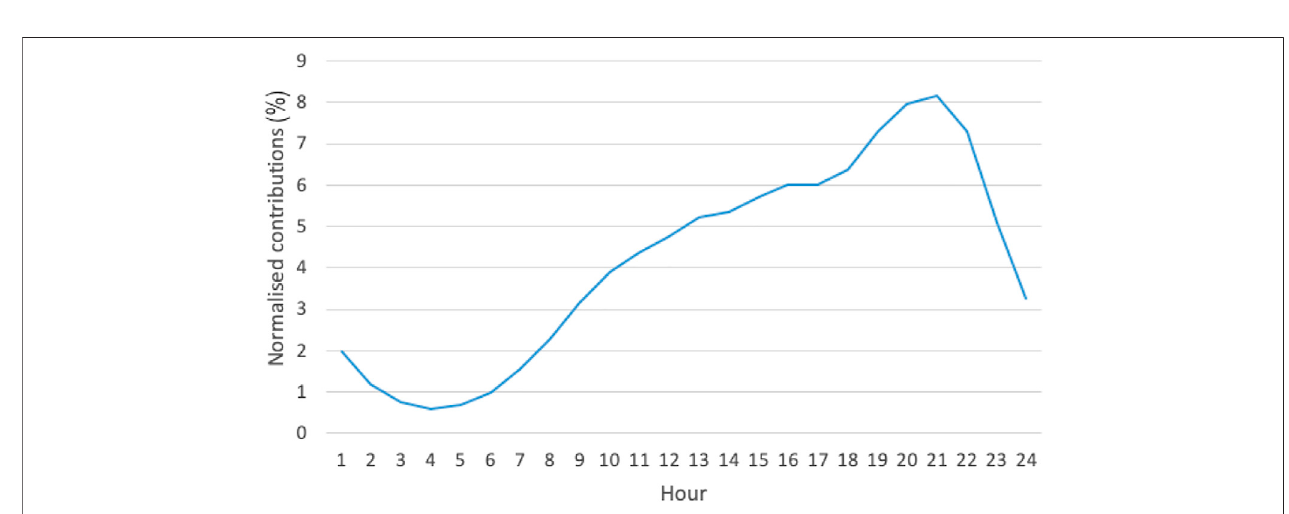
FIGURE 5 | The universal curve showing the average contributions per hour for the 20